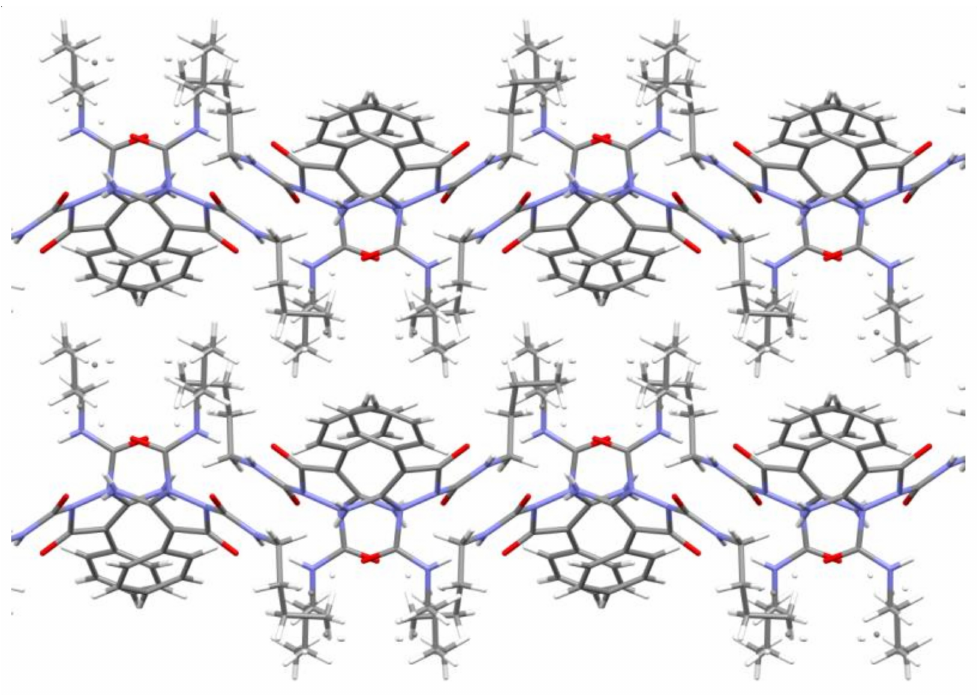
Figure 2. The crystal packing of 1 , viewed along the c axis. The molecules in structure 2 create gaps into which the disordered solvent molecules are fit (Figure 3). The DMSO molecules form hydrogen bonds of the N-H . . . O(DMSO) type. A water molecule stabilizes the structure with three hydrogen bonds with two 2 molecules and one DMSO molecule (Table 3).